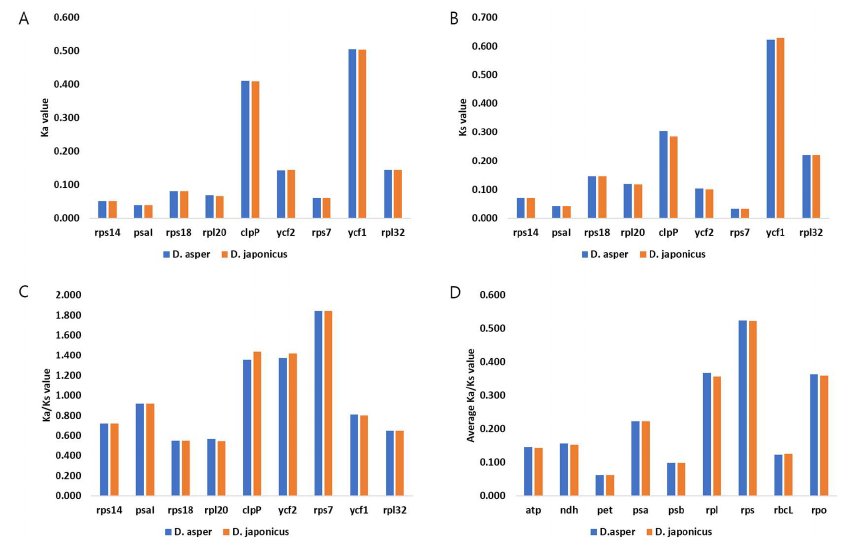
Figure 3. The analysis of Ka, Ks, and Ka/Ks values of the chloroplast genomes of D. asper , D. japonicus , and L. japonica . The ratio of non-synonymous substitution rate (Ka) to synonymous substitution rate (Ks) was calculated for 78 conserved protein-coding genes. ( A ) Ka values of genes with Ka/Ks > 0.5. ( B ) Ks value of genes with Ka/Ks > 0.5. ( C ) Ka/Ks values of specific genes. ( D ) Average Ka/Ks values of gene groups.